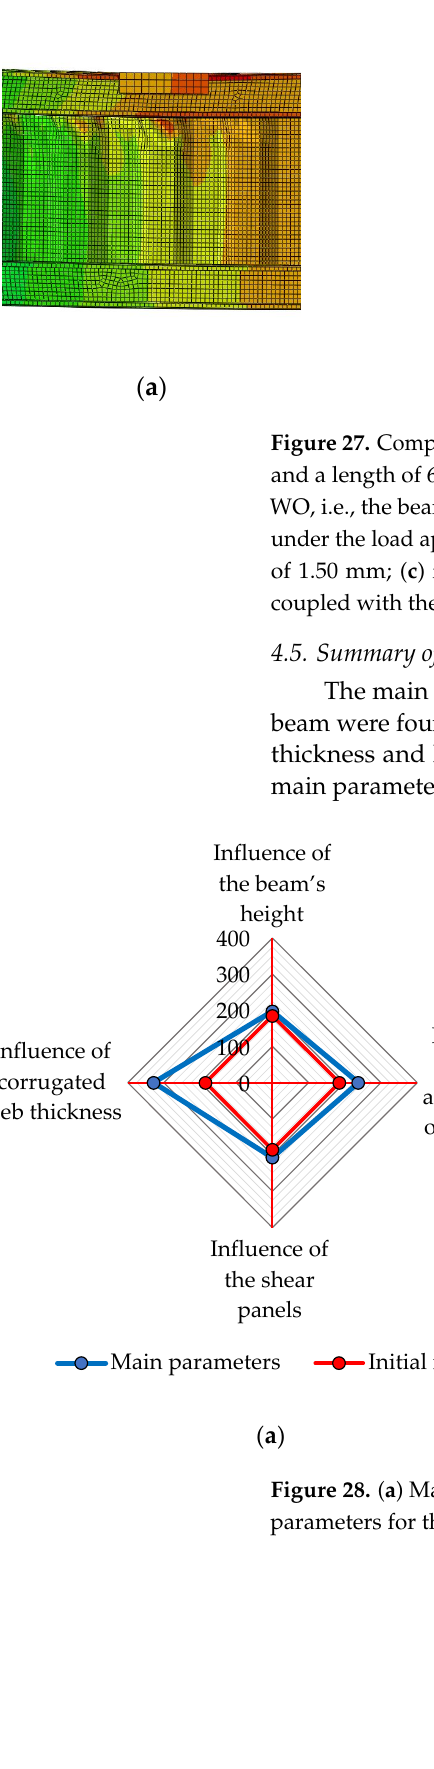
( b ) Figure 29. ( a ) Main parameters for the beam with a length of 7500 mm and a web opening; ( b ) main parameters for the beam with a length of 7500 mm without a web opening.